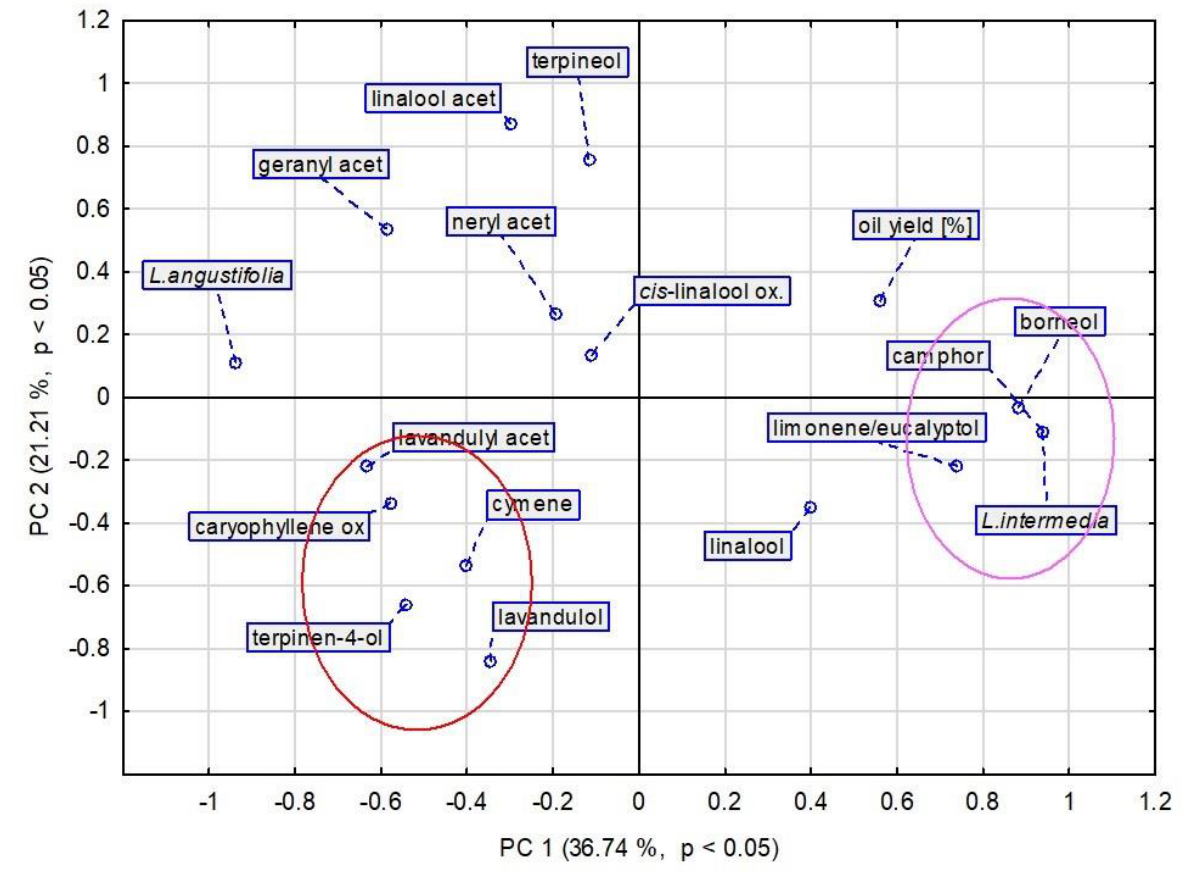
Figure 7. PCA score plot of all obtained data based on average content of EO components in different species. PC — principal component.